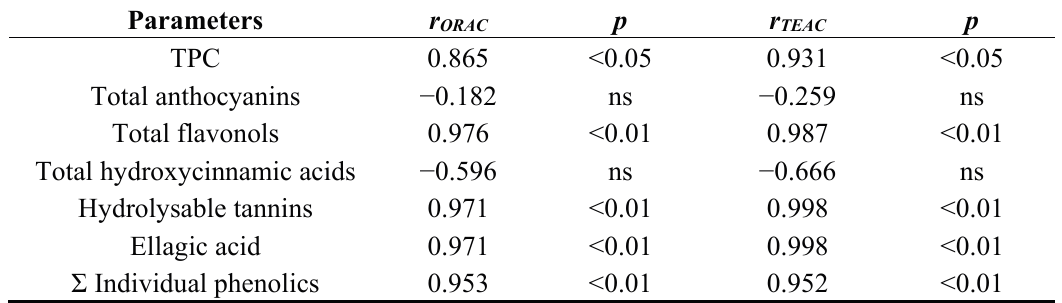
Table 5. Pearson’s correlation coefficients ( r ) and their statistical significance for the correlations of total phenolic compounds (TPC) and individual phenolic compounds determined by HPLC-DAD-ESI/MS n with the oxygen radical absorbance capacity (ORAC) and Trolox equivalent antioxidant capacity